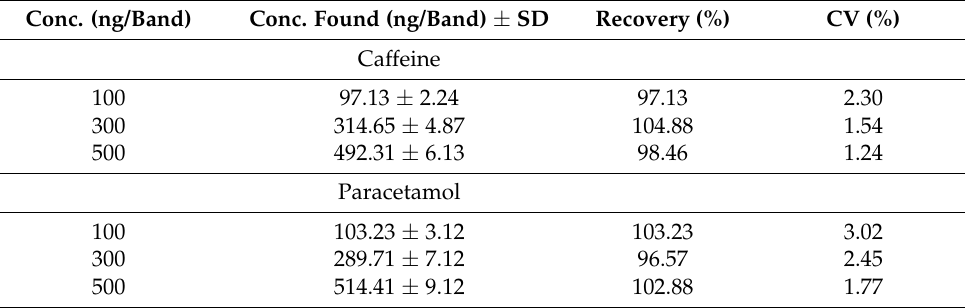
Table 5. Measurement of the accuracy of caffeine and paracetamol for the greener normal-phase HPTLC method (mean ± SD; n =